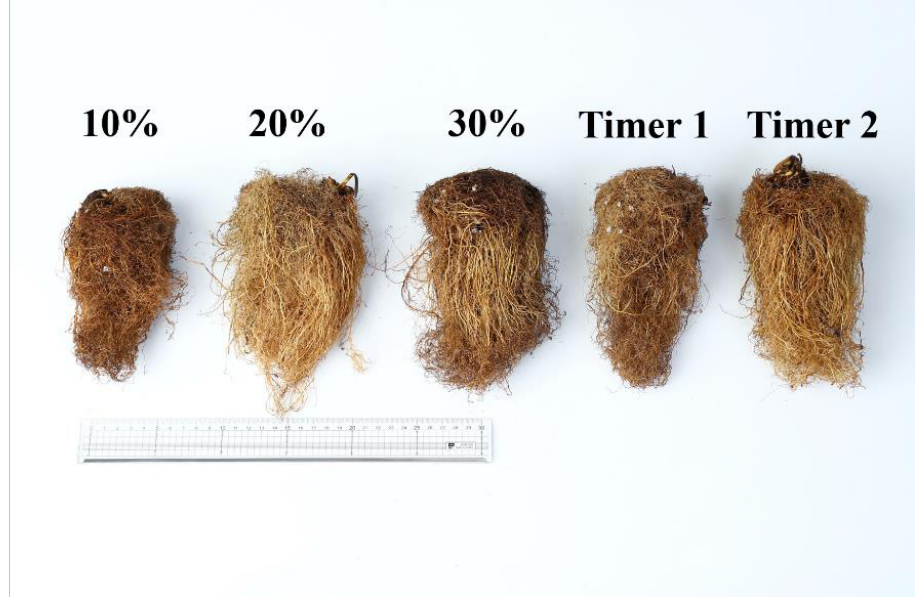
Figure 4. Rhizosphere differences of strawberry ‘Kuemsil’ as affected by the nutrient solution supplying system using different drainage rate levels and timer (Drainage rate 10%, 20%, or 30%; Timer 1, timer set for 4 applications daily; Timer 2, timer set for 6 applications daily).